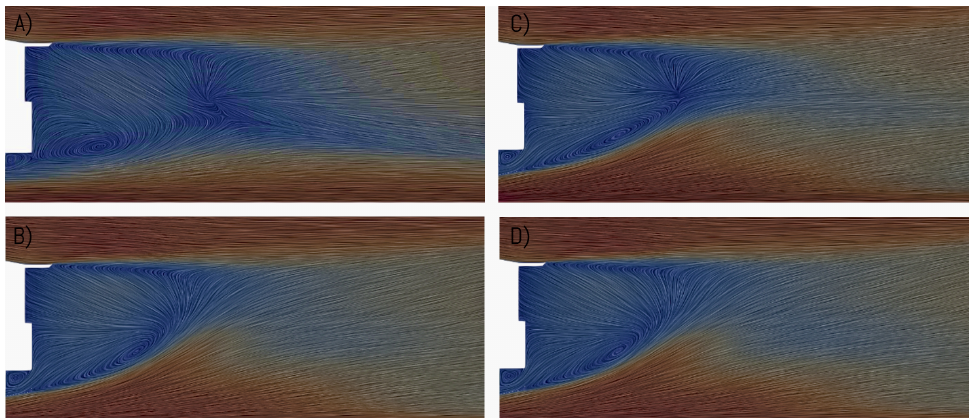
Figure 17. Details of the velocity distributions on the YZ-plane of ( A ) baseline, ( B ) Venturi diffuser, ( C ) Venturi skirts, and ( D ) Venturi frontal